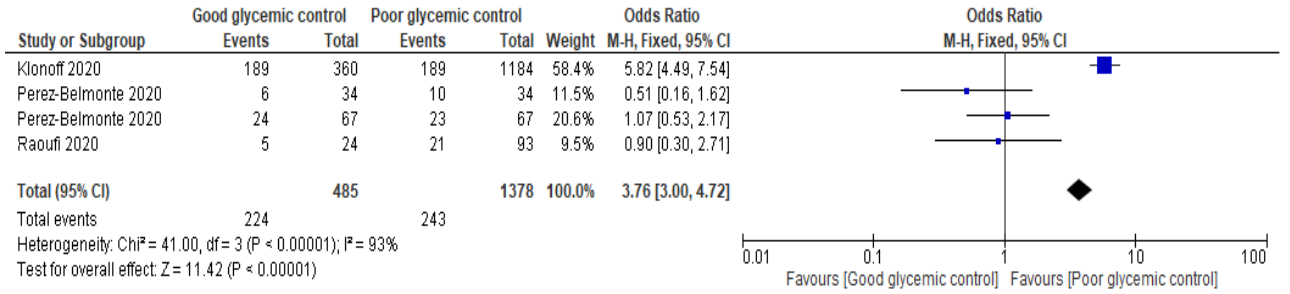
Figure 4. Forest plot for the outcome of death in the well-controlled vs. poorly controlled glycemic comparison (calculated using a fixed-effects OR of 3.76) [3,29,30].